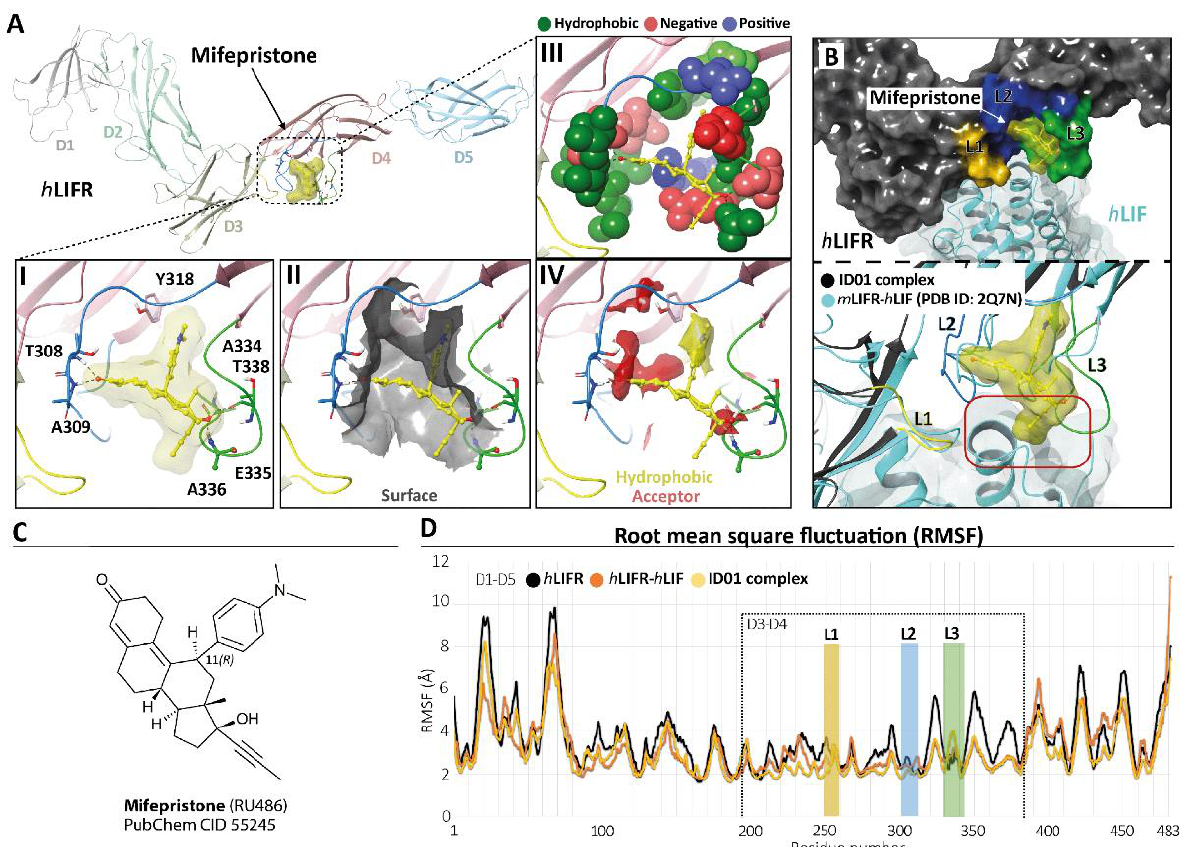
Figure 4. Modelling. ( A ) h LIFR-ID01 complex. The protein backbone is displayed in ribbon and coloured by distinguishing the five domains (D1–D5). In the zoom view, (I) the ID01 binding mode of mifepristone (displayed as yellow ball and stick), highlighting the “T-inverted” shape; (II) the “T-inverted” shape well-fit with h LIFR surface; (III) the main residues involved in the interactions with the mifepristone; (IV) the hydrophobic (yellow) and hydrogen bond acceptor (red) maps fit with mifepristone. The principal residues are labelled and highlighted in wireframe or CPK(A3), while hydrogen bonds are in dashed black lines. ( B ) Superimposition between the ID01 best MM/GBSA value pose (black) and the m LIFR- h LIF X-ray (PDB ID: 2Q7N) (cyan). The three loops L1 (255-VSASSG-260), L2 (303-NPGRVTALVGPRAT-316), and L3 (332-KRAEAPTNES-341) are highlighted in yellow, blue, and green, respectively. The red rectangle highlights the clash with the propyne moiety of mifepristone and h LIF. ( C ) Two-dimensional structures of mifepristone. ( D ) The root means square fluctuation (RMSF) plot of the three compared systems (ID01 complex, h LIFR- h LIF, and h LIFR) during 100 ns of MDs.